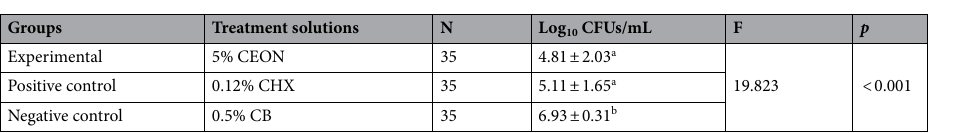
Table 2. Numbers of aciduric bacterial CFUs within biofilms according to treatment solution. CFUs colony-forming units, CEON cinnamon essential oil nanoemulsion, CHX chlorhexidine gluconate, CB cocamidopropyl betaine. p value obtained from one-way analysis of variance. All values are presented as means ± standard deviations. a, b Different letters indicate significance by Scheffe’s multiple comparison test at α = 0.05.